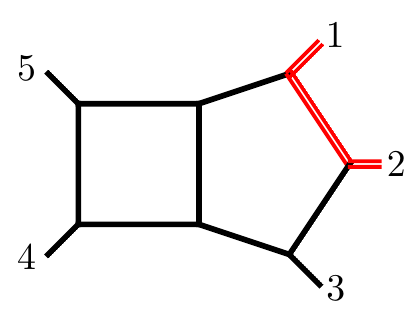
Figure 1 . The pentagon-box topology contributing to pp → t ¯ tj . Black lines denote massless particles and red double-lines denote massive